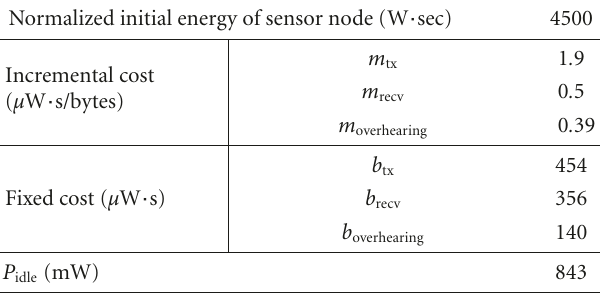
Table 1: Energy consumption parameters configuration of lucent IEEE802.11 WaveLAN card [17].